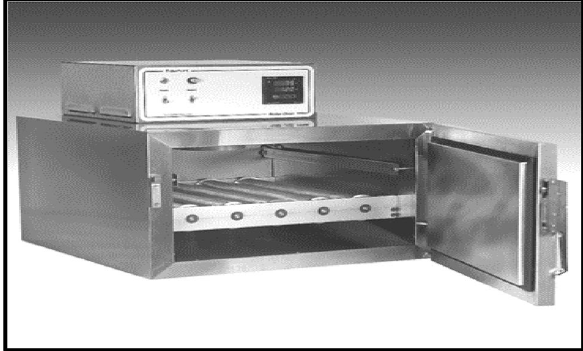
Fig. 2 Roller oven and accessories (Fann Instrument Company